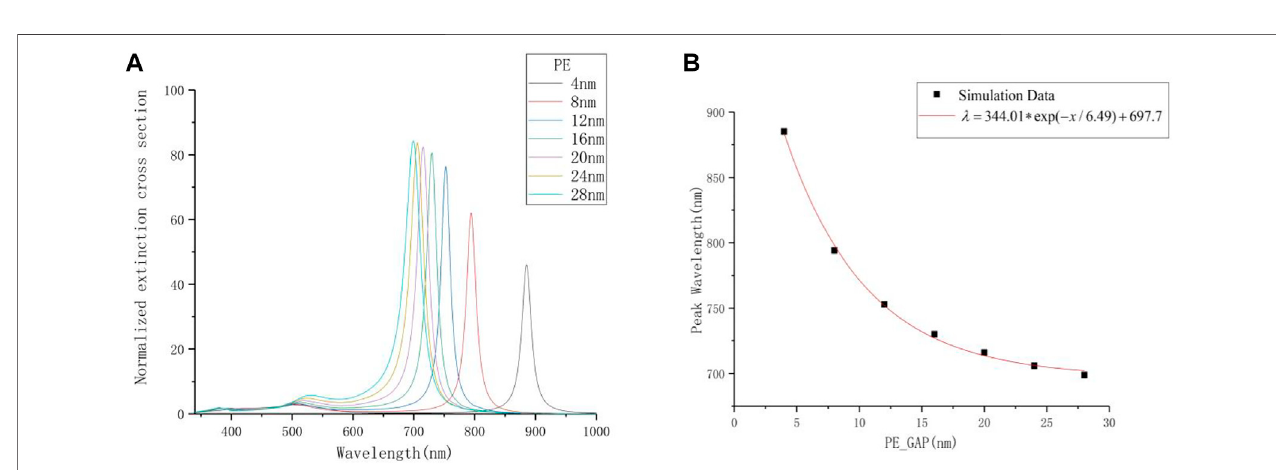
FIGURE 2 | (A) The extinction spectrum with different thickness of PE. (B) The relationship between the thickness of PE and the resonance peak.